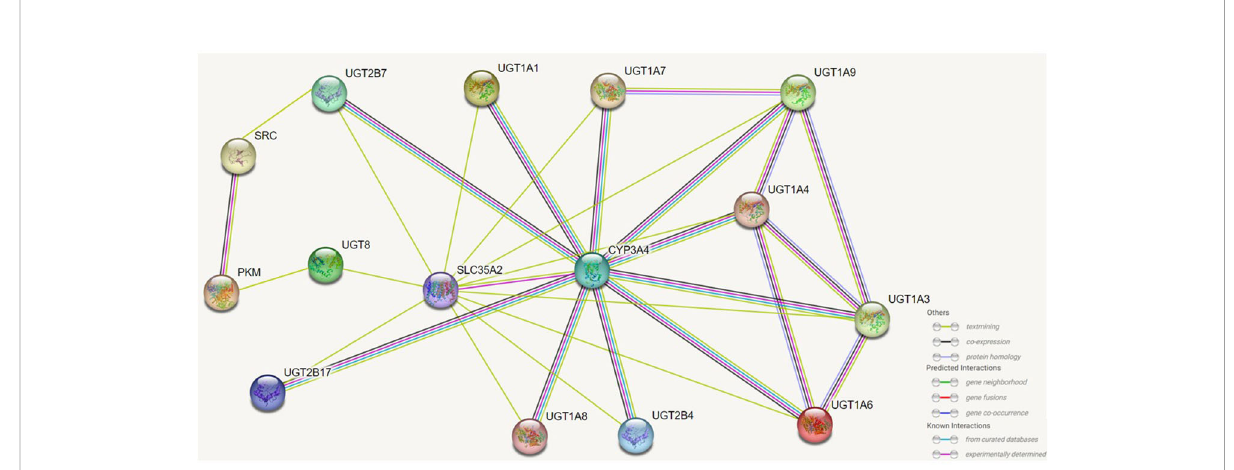
FIGURE 5 Effects of UGTs interacting with isotypic or heterotypic proteins on their function. UGTs can interact with proteins of the same isoform and different isoforms and the activity of UGTs will be altered and consequently the metabolism and capacity of the substrate will be altered. Through protein interactions, there are members of the UGTs family whose regioselectivity for substrates is also altered, and there are also interactions of UGTs with other proteins that can also localise the site of biochemical reactions. The fi gure lists which proteins UGTs can interact with, as well as predicting the way in which some of these proteins interact with each